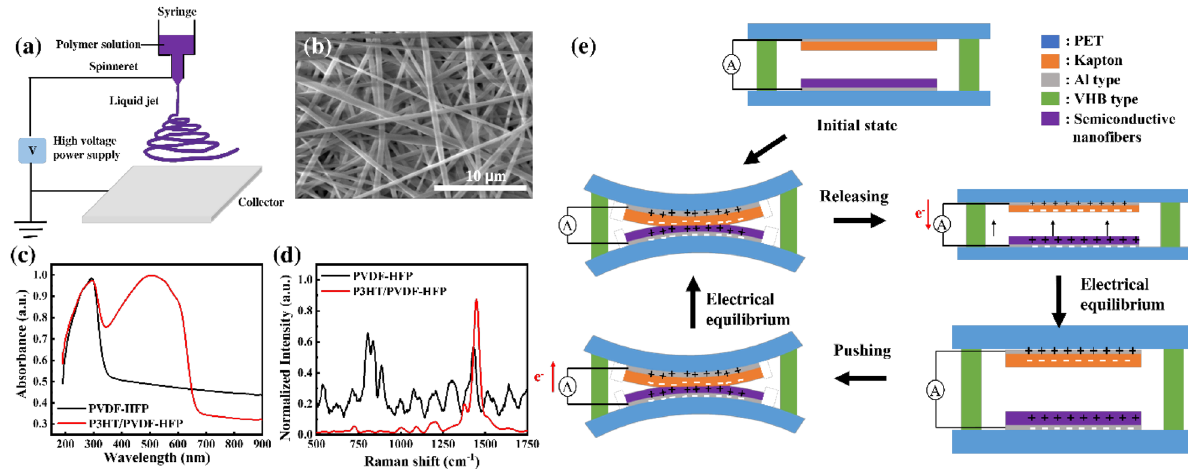
Figure 1. ( a ) Schematic representation of the electrospinning set-up for producing the nanofibers. ( b ) SEM images and ( c ) UV–Vis and ( d ) Raman spectra of electrospun nanofibers composed of pristine PVDF-HFP and 3 wt% P3HT/PVDF-HFP. ( e ) Simplified schematic representation of the electric power generation process of semiconductive nanofiber–based